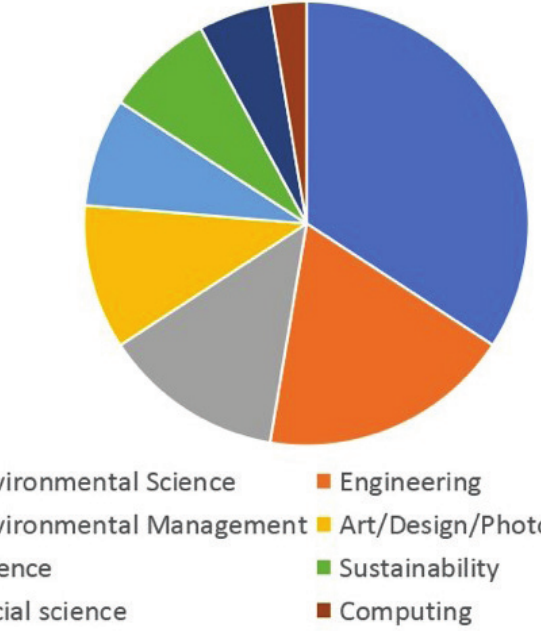
Figure 2: Proportion of urban ecology students (N=38) by focal area of study. Environmental related majors made up nearly half of the total number of students, with Engineering and Art/ Design/Photo also contributing. In all, thirteen different majors were